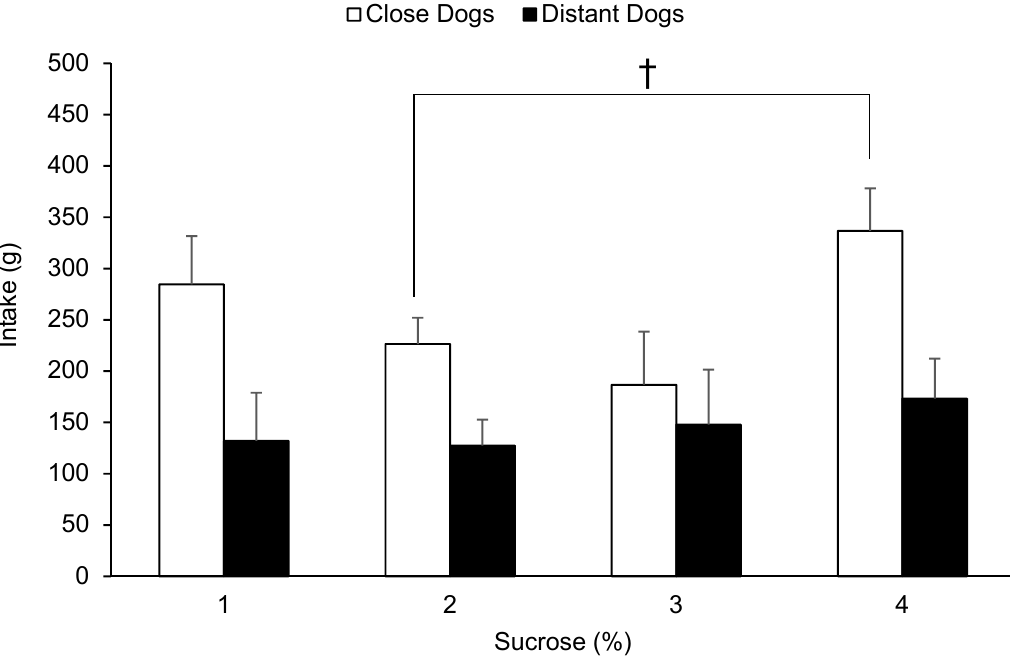
Figure 1. Consumption (least square means + standard error) of kennelled dogs in front of different sucrose solutions (1%, 2%, 3%, and 4%) during a 20 min acceptability test according to the human-approach test results (close or distant) previously assigned († p < 0.1).